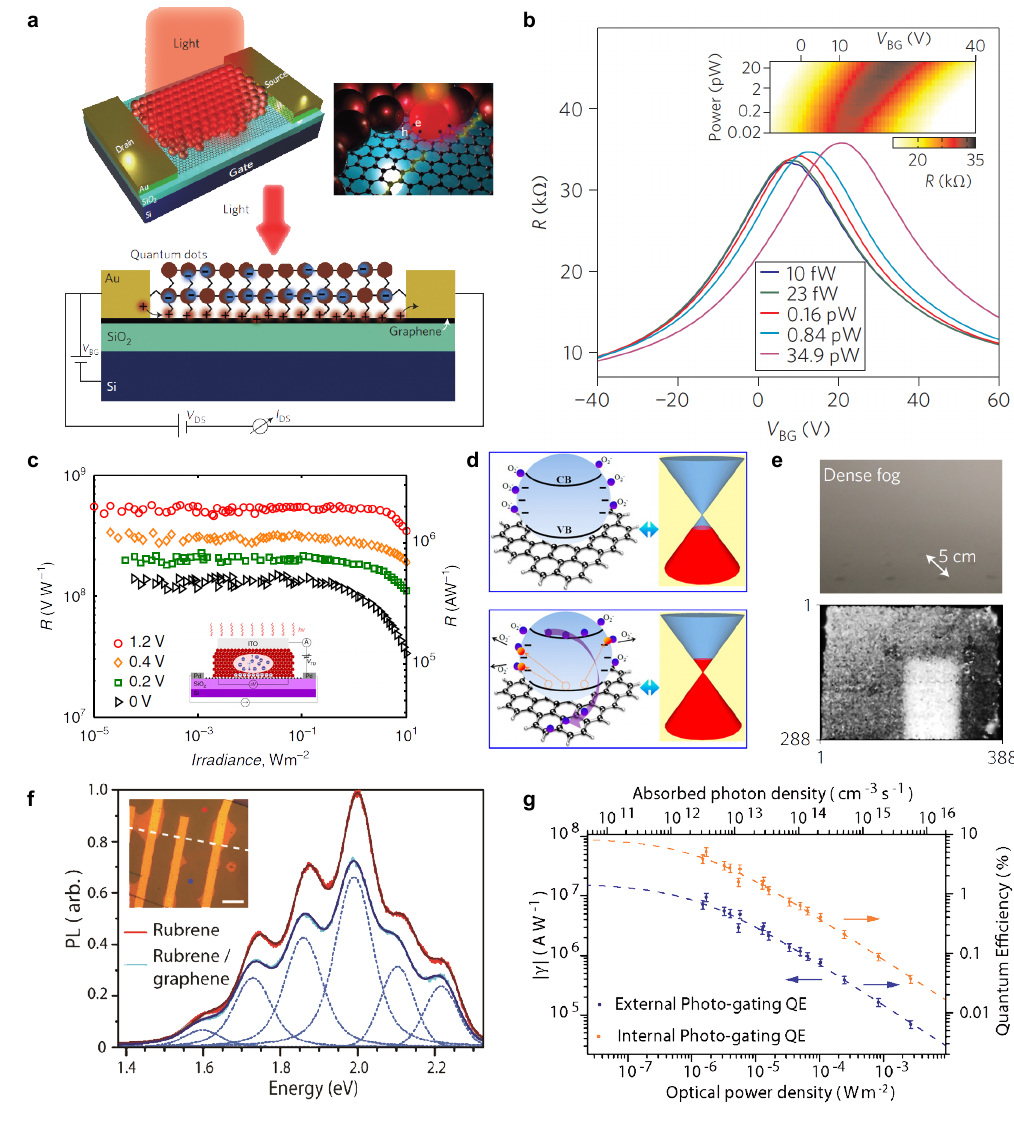
Figure 6. Quantum Dots and Organic graphene hybrids. ( a ) schematic of PbS quantum dot (QD) sensitised graphene channel with electrical connections. ( b ) back-gate dependence of graphene channel resistance under different illumination powers demonstrating photogating effect. The inset shows a two-dimensional plot of power and back-gate voltage. Reproduced with permission from Konstantatos et al. [82] Copyright 2012, Nature Publishing Group (London, UK); ( c ) plateau in responsivity vs optical power shows the extended LDR of ITO-QD-graphene phototransistor. Reproduced under CC-BY 4.0 from Nikitskiy et al. [88], 2016; ( d ) oxygen assisted charge-trapping process in ZnO QDs. Reproduced with permission from Shao et al. [85] Copyright 2015 American Chemical Society; ( e ) photos taken in dense fog of a cylindrical object by a conventional silicon (upper) and PbS-graphene hybrid (lower) sensor array. Reproduced with permission from Goossens et al. [127] Copyright 2017, Nature Publishing Group; ( f ) photoluminescence of rubrene single crystal with (blue) and without (red) graphene underlayer. The inset shows an optical image of a device where coloured dots highlight the position where the photoluminesence (PL) spectra were acquired. ( g ) quantum efficiency (red) and responsivity (blue) as a function of incident optical power density for the device in panel f . Reproduced with permission under CC-BY 4.0 from Jones et al. [99],